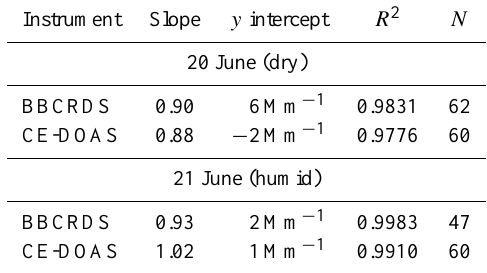
Table 3. Analysis of the extinction coefficients measurements by the three instruments in aerosol-free conditions. Two data sets are analysed: (1) stable operating conditions refers to data when the baseline was stable for an extended time, and is indicative of the measurement precision of the instrument; (2) all aerosol-free con- ditions describes all the extinction data for each day and provides a measure of system accuracy and instrumental drift. Values are reported as the mean and standard deviation, 1 σ , of the aerosol extinction coefficient for N spectra at the native time resolutions of the instruments (60s for BBCRDS and CE-DOAS, and 5s for IBBCEAS).